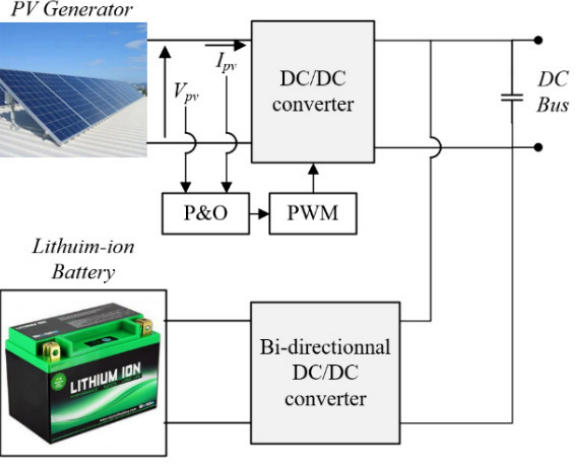
Figure 4. PV–ESS configuration.